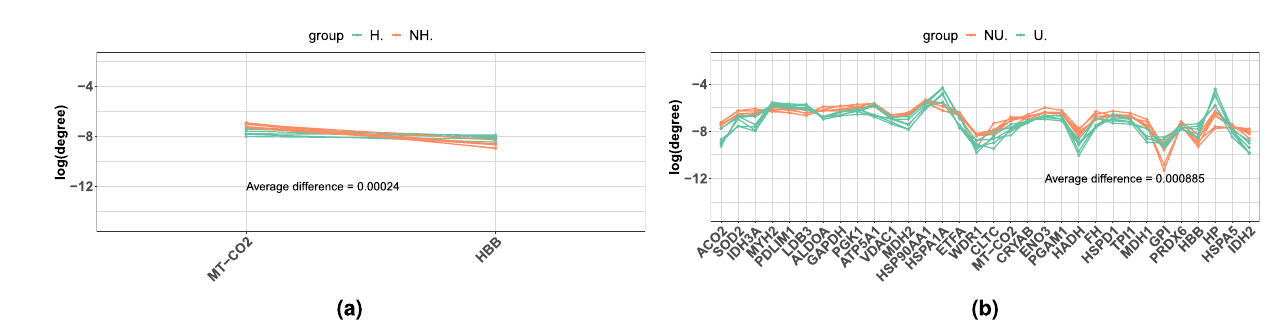
Figure 4. Average degree comparison for SSPs. The line plots show the trends for the average degree computed for the SSPs, whose names are provided on the x axis. Lines representing healthy control samples (NH and NU) are coloured in orange, while lines representing treated samples (H and U) are coloured in green. Average differences are also